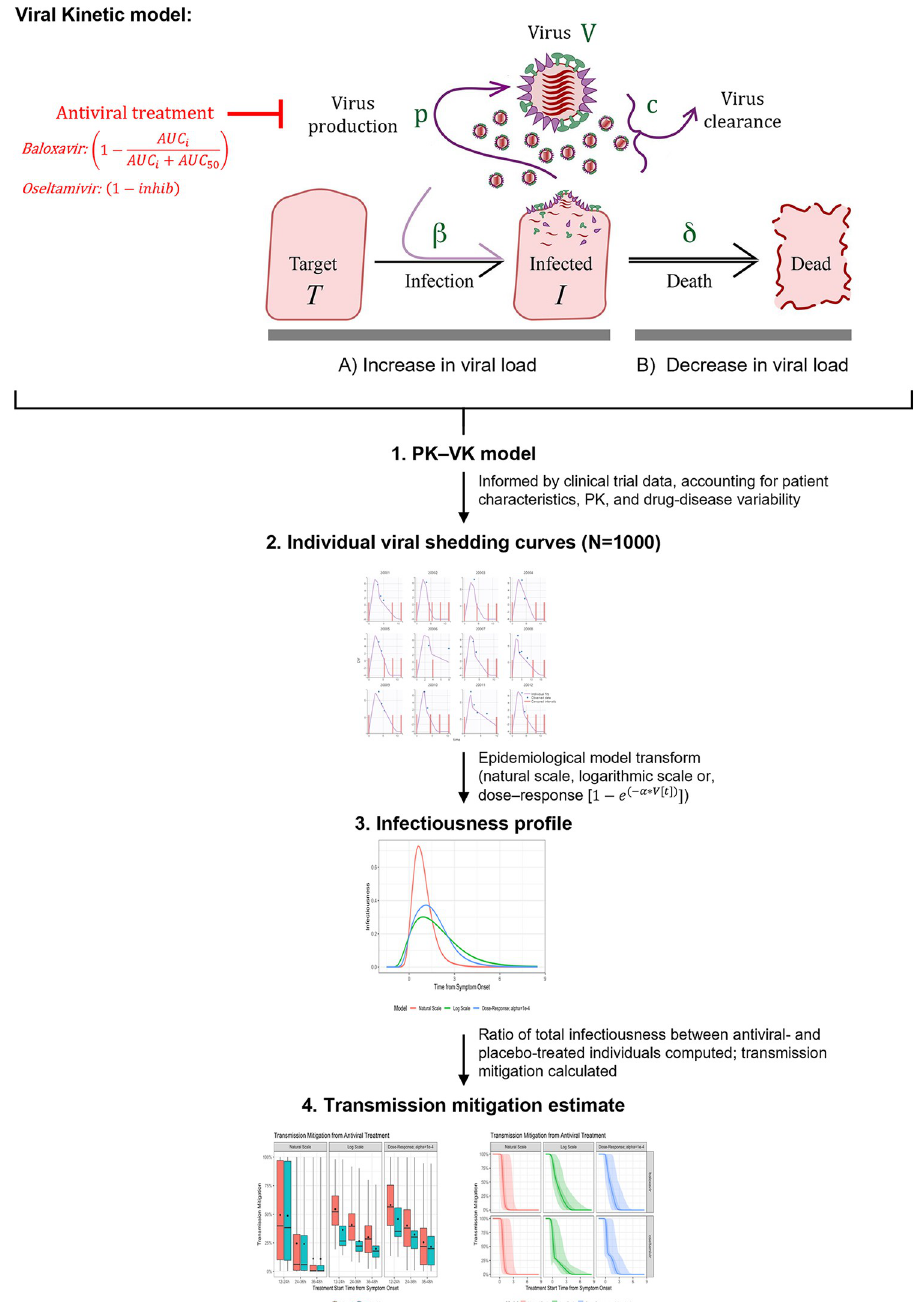
Fig 1. Schematic representation of viral kinetic model and study overview. The viral kinetic model assumes that the initial viral load increases (A) by infection (rate β ) of and replication within target cells (T), which subsequently shed progeny virions (free virus, V; virus production rate, p). Antiviral treatment prevents the increase of viral load via inhibition of virus production; for baloxavir, this was informed by PK estimates from clinical trial data, whereas an inhibition factor was used for oseltamivir (in lieu of PK model data). The viral load decreases (B) with the death (rate δ ) of infected cells (I) and by clearance of free virus (rate c). The PK–VK model was used to generate viral shedding curves (i.e. viral titer time courses) for 1000 simulated individuals treated with either baloxavir, oseltamivir, or placebo. These shedding curves were transformed to generate infectiousness profiles using one of three epidemiological models, whereby infectiousness was assumed to be proportional to viral load on natural-scale, a logarithmic-scale, or a dose– response transform. Transmission mitigation (i.e. the reduction in secondary transmission) was computed by comparing the area under the respective model-transformed infectiousness profiles for individuals treated with an antiviral or placebo. Figure adapted from Kamal et al. 2015 [23]. PK, pharmacokinetics; VK, viral kinetics. https://doi.org/10.1371/journal.pcbi.1010797.g001 PLOS Computational Biology | https://doi.org/10.1371/journal.pcbi.1010797 January6,